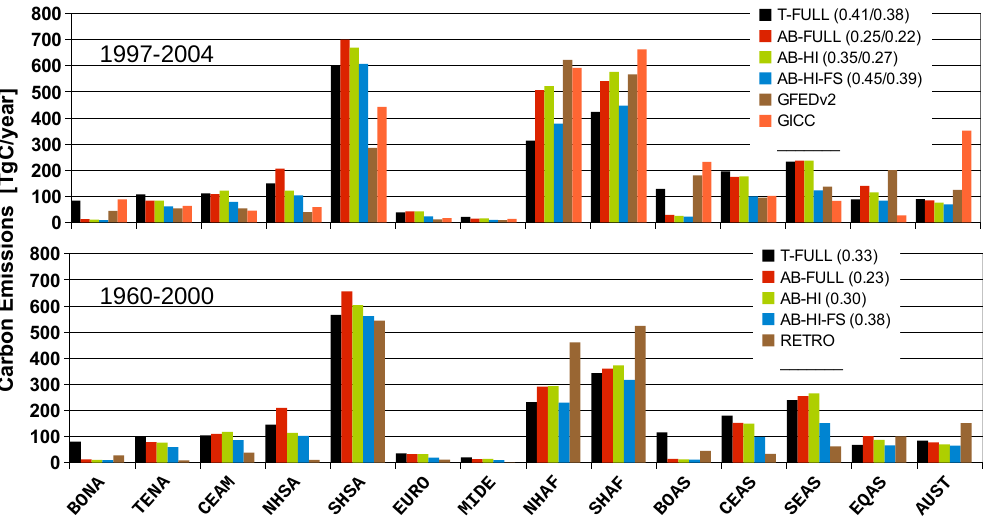
Fig. 4. Annual mean total (wildfire plus deforestation) fire carbon emissions in [TgC/year] for different regions compared to GFEDv2 (van der Werf et al., 2006), GICC (Mieville et al., 2010), and RETRO (Schultz et al., 2008). The model simulations are averaged over the corresponding observational period (1997–2004 or 1960–2000, respectively). The number in brackets denote global spatial correlation coefficients between simulations and fire products (for the upper panel the first numbers refers to GFEDv2 and the second to GICC). Regions are defined in Fig. A3.